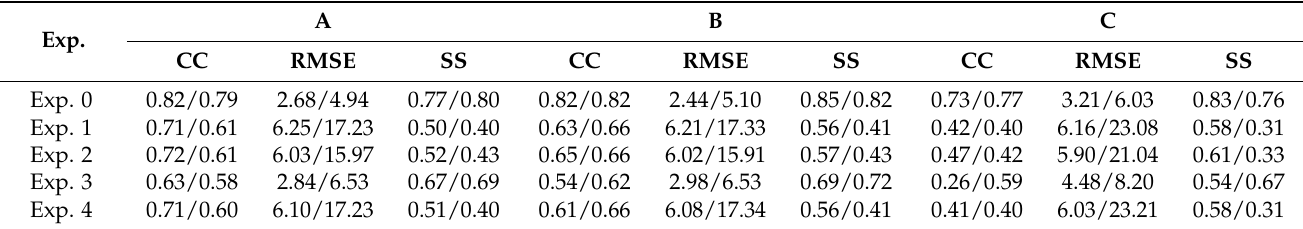
Table 3. Model validation statistics of salinity at the observational sites (value at surface layer/value at bottom layer). Exp.